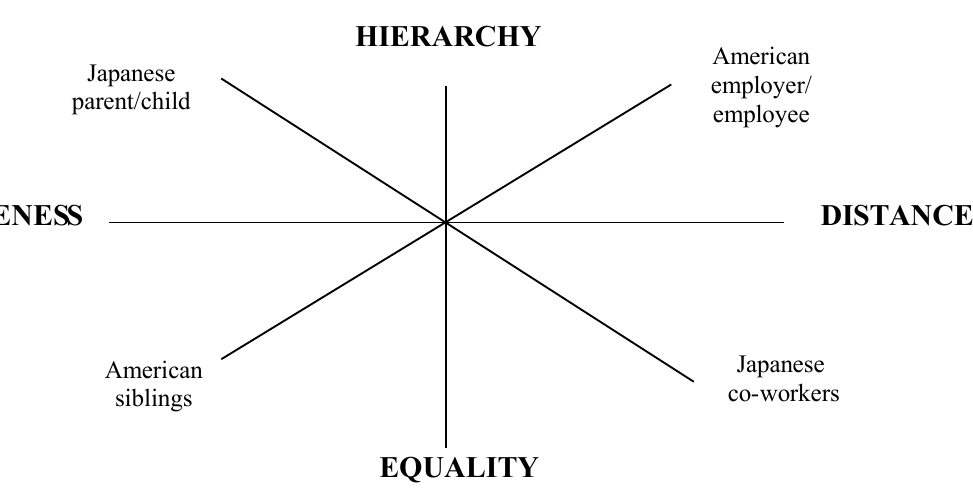
Tannen’s power/connection grid with American and Japanese cultural views (Adapted from Tannen 2003a,